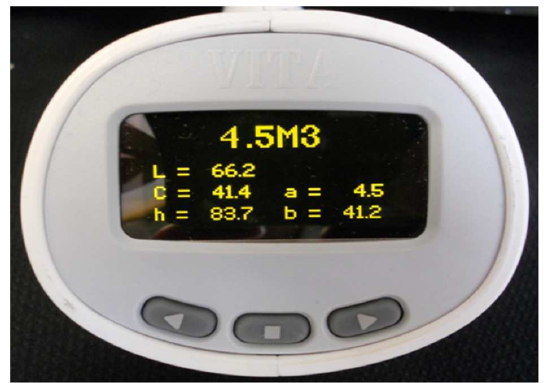
Figure 2. The Easyshade compact spectrophotometer.